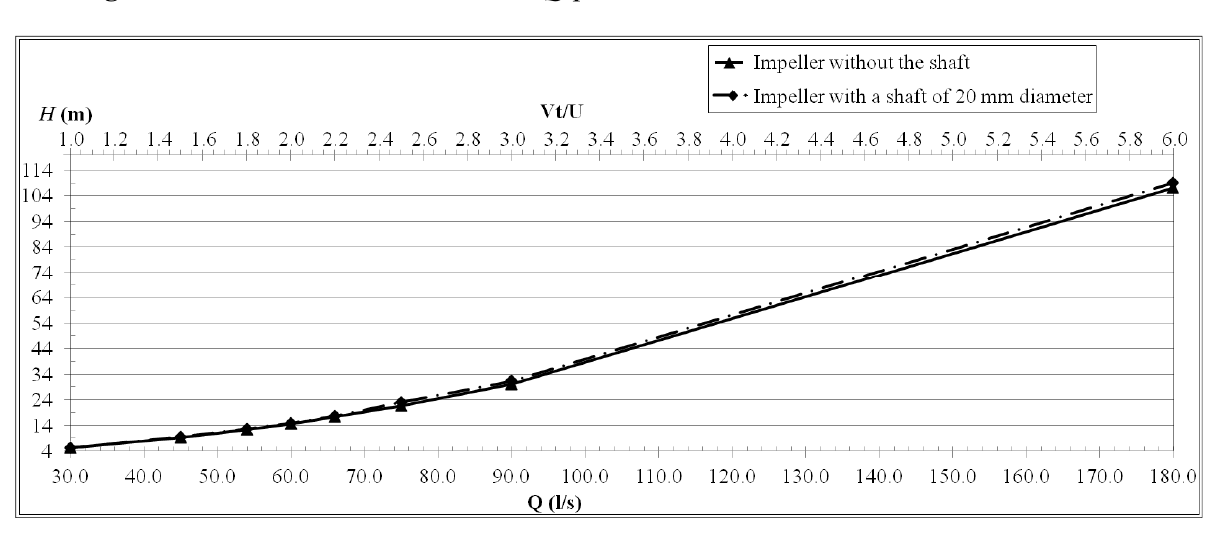
Figure 20. Characteristic curves on H-Q plane of the turbine with and without the